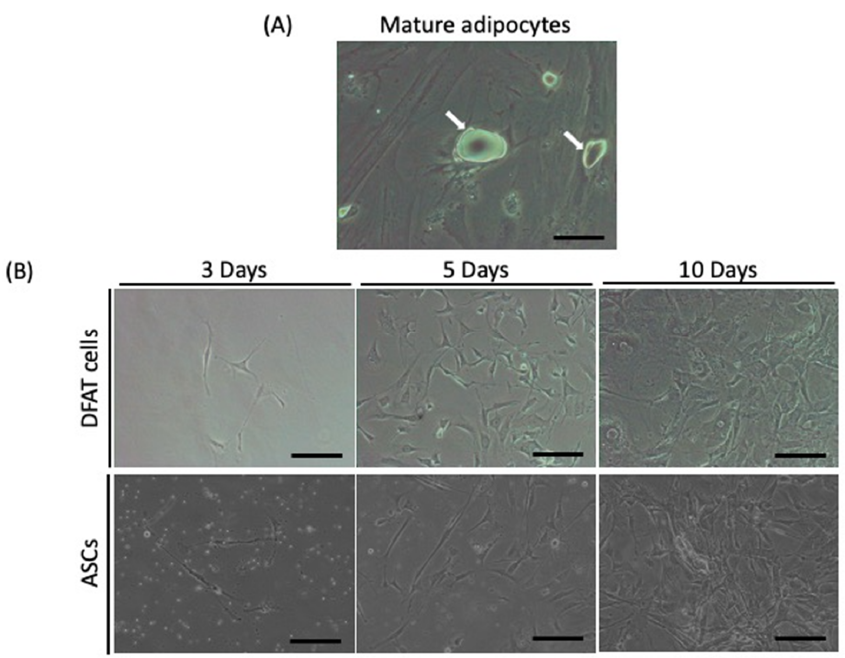
Figure 2. ( A ) Morphology of mature adipocytes. Mature adipocytes had a large lipid droplet (white arrows). ( B ) DFAT cells and ASCs at 3, 5, and 10 days. Both DFAT cells and ASCs showed fibroblast-like shapes. Scale bar: 10 µ m.